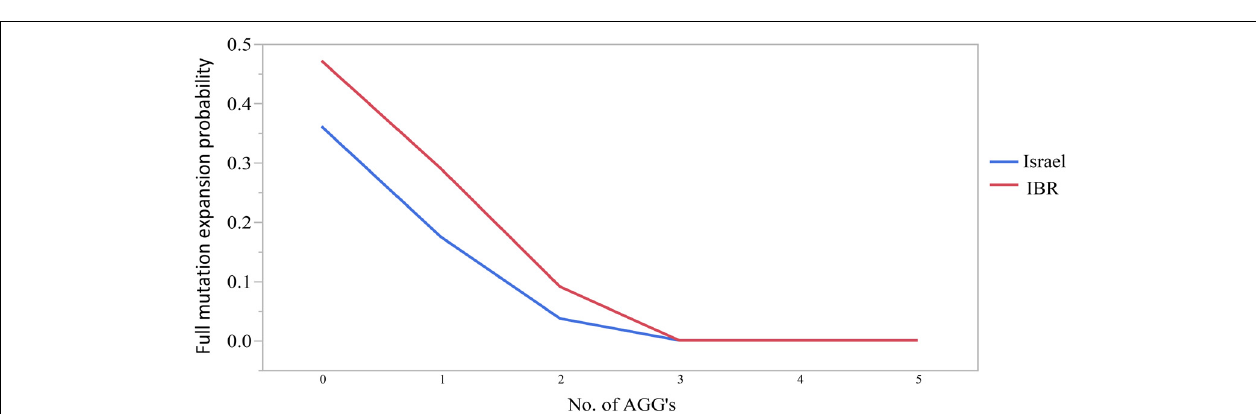
FIGURE 1 | The effect of the maternal number of CGG repeats upon the probability for a full mutation expansion.